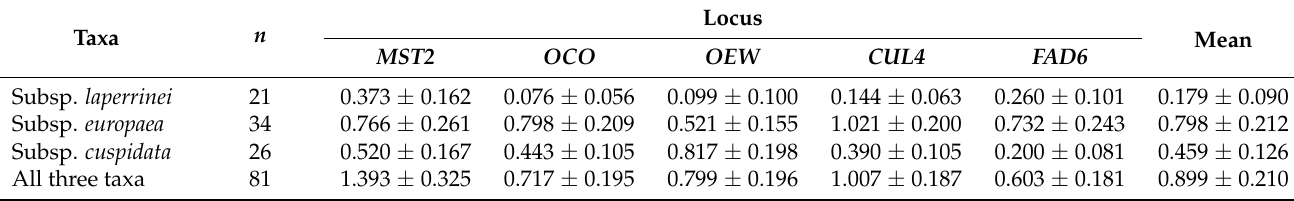
Table 1. Estimates of nucleotide diversity ( π in % [43]) in five gene segments (loci) among three olive taxa. π is given for each locus and on the total dataset. n is the number of sequences (haplotypes) used for each taxon. The standard error of these values was estimated with bootstrapping on haplotypes (100 replicates). Estimates for the Mediterranean ( europaea ) and African ( cuspidata ) olives are based on sequences isolated from 17 and 13 native wild olives, respectively [36].